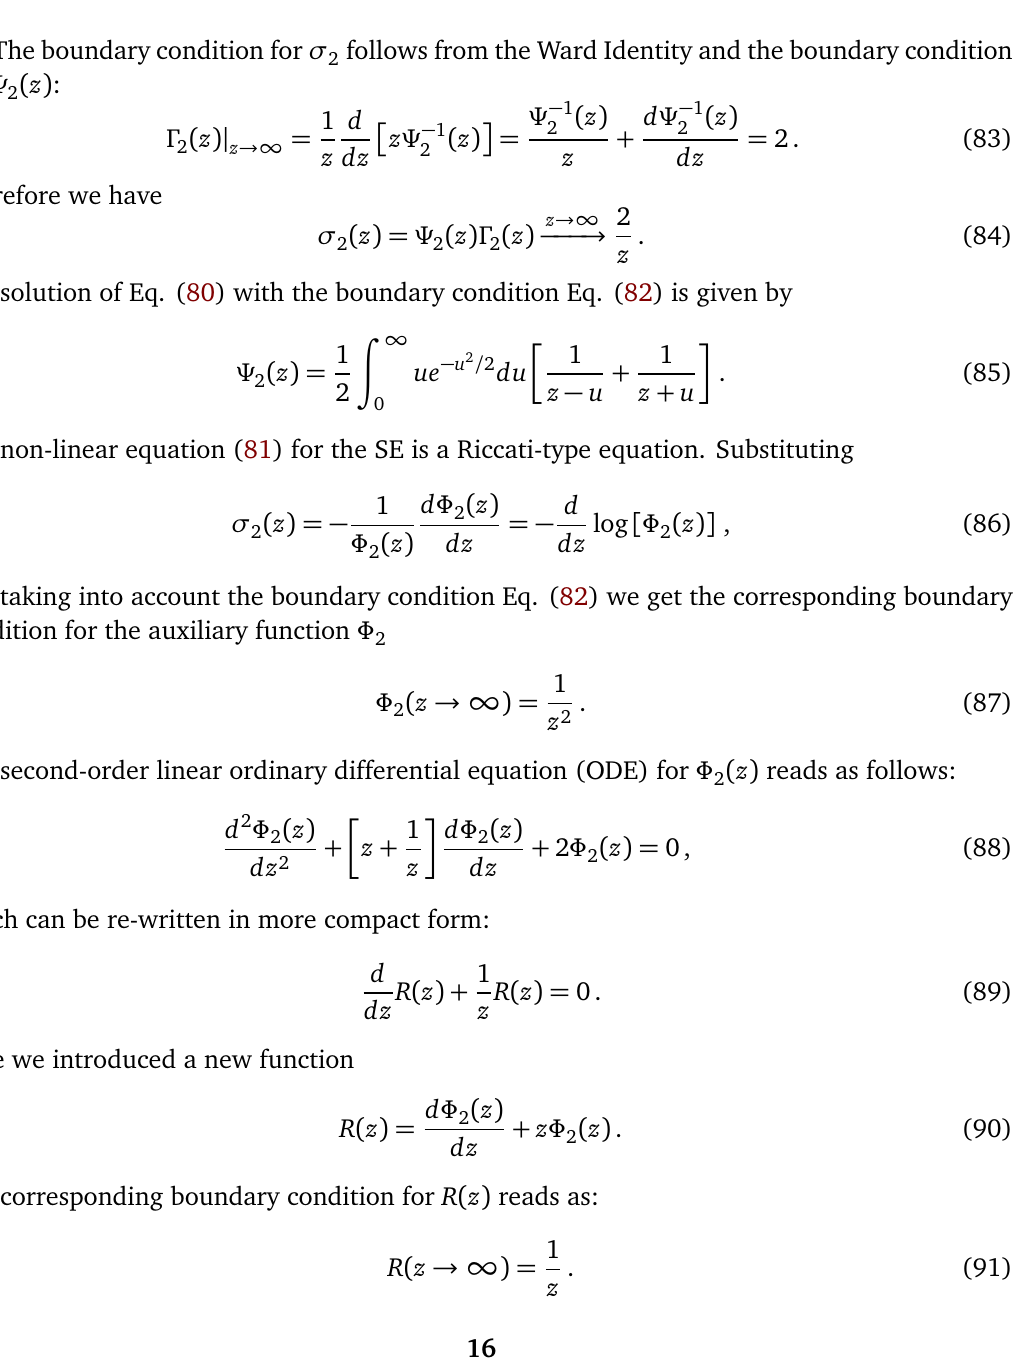
Figure 9: Irreducible self-energy part diagram in the first a) and third b) orders of the perturbation theory. Second order diagram is topological impossible. c) first non-trivial diagram for the